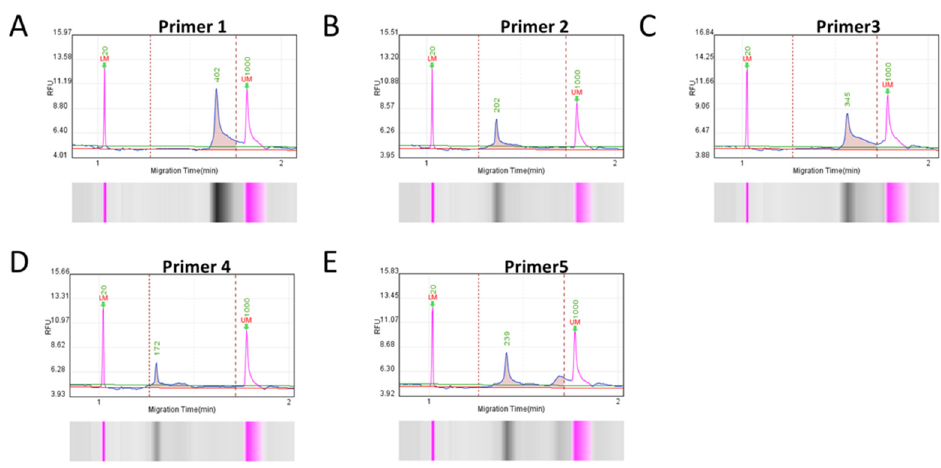
Figure 1. Capillary electrophoresis of RAA-amplified products, corresponding to five pairs of primers from ( A – E ). Five pairs of primers were used for RAA amplification; the product was analyzed by capillary